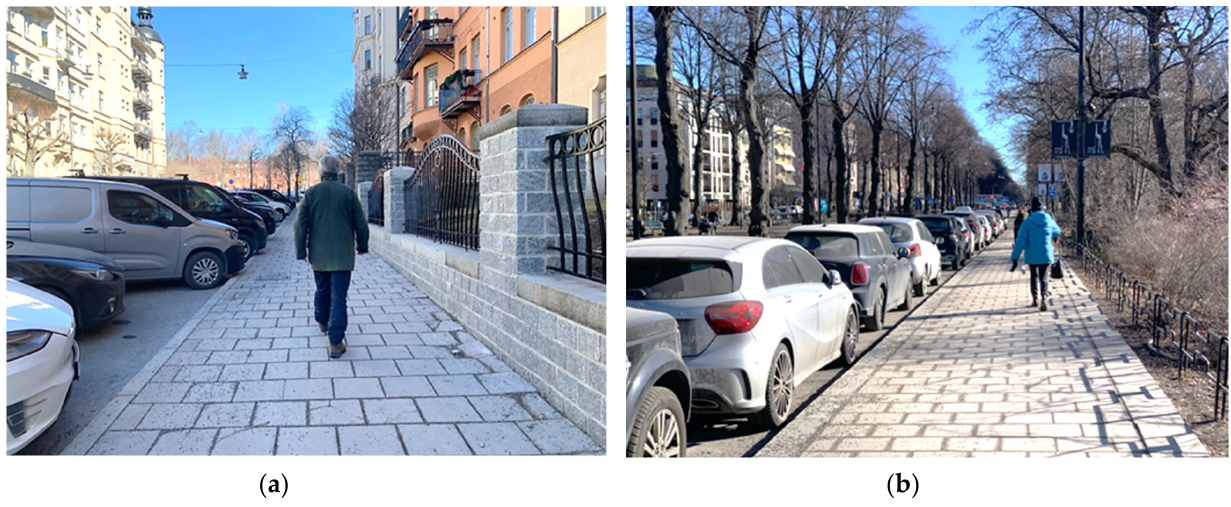
Figure 11. ( a , b ) Two photos from the inner urban study area of Stockholm in March 2022. The predominant street network is laid out in a grid pattern with a mixture of different streets. Cars are often parked along streets protecting the pedestrians (physically) by providing a barrier that sometimes will hide the vehicle flow and distance the pedestrians from the vehicles. However, noise will reach those on the pavement regardless of the barrier provided by the vehicles. When data were collected in May 2005, the trees had leaves. Photo: Dan